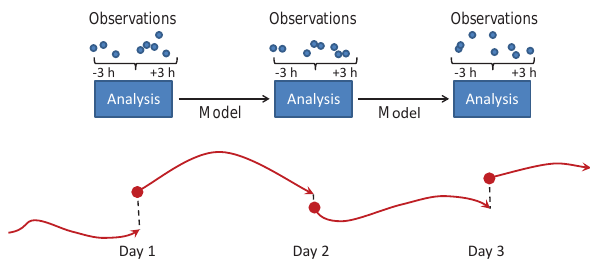
Figure 1. Schematic diagram of EC-CAS forward model cycles. Meteorological analyses were precomputed by CMC’s operational global deterministic prediction system using all observations col- lected in a 6h window centred on the analysis time. These analyses are represented by blue boxes. CO 2 tracers are added to these anal- yses to form an initial condition (solid red circles) for launching a 24h forecast (red arrows) using the coupled meteorological/tracer model starting at 00:00UTC of each